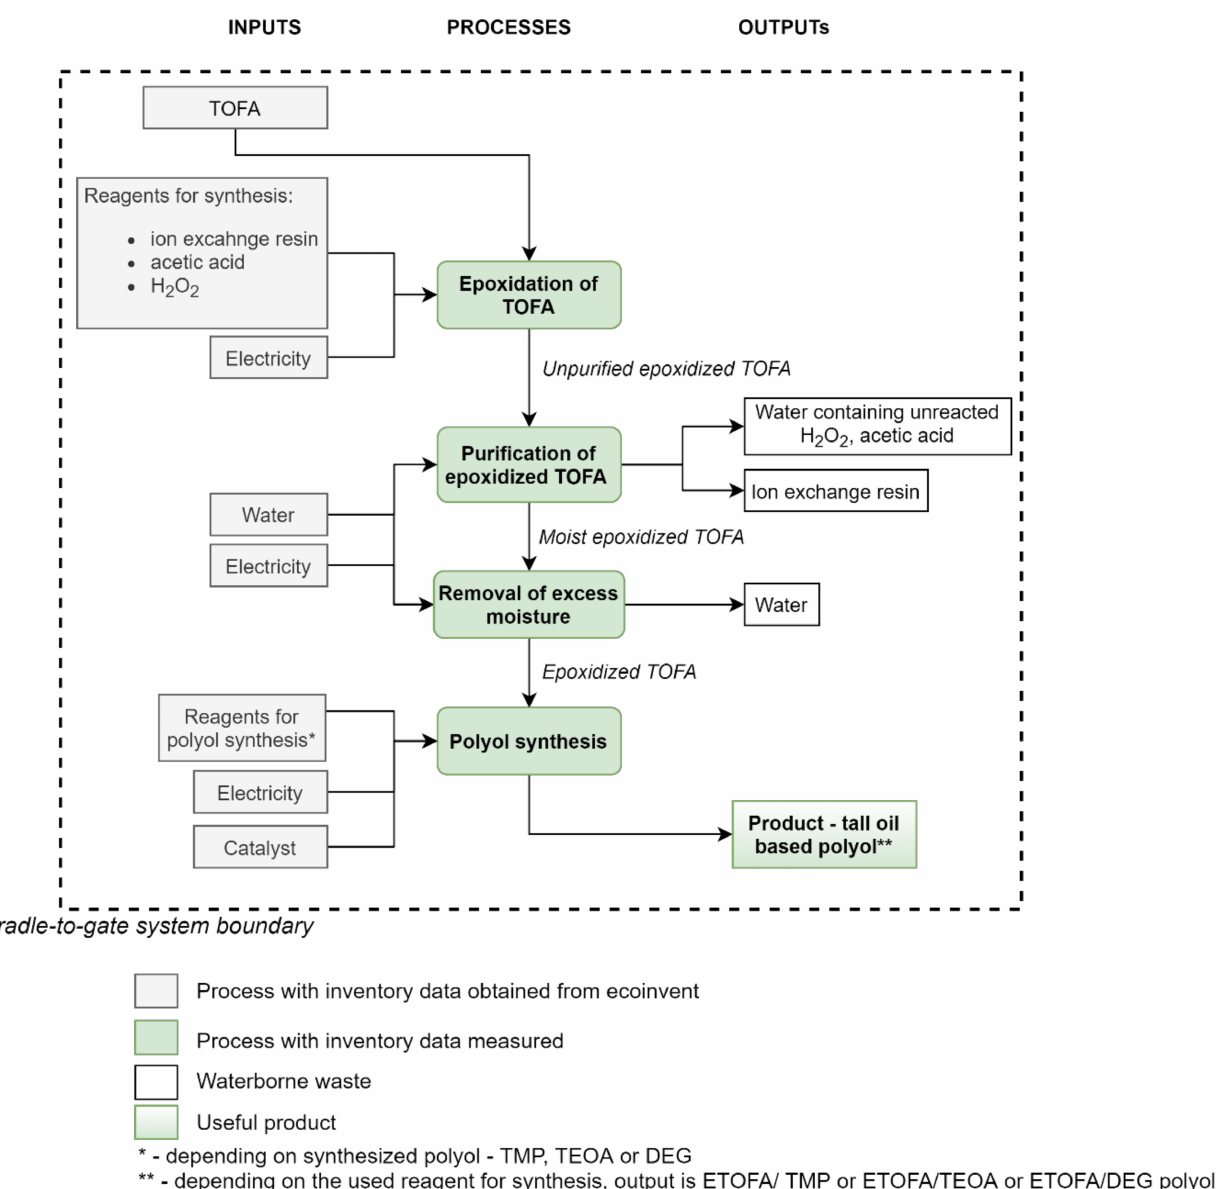
Figure 1. System boundaries of TOFA based bio-polyol